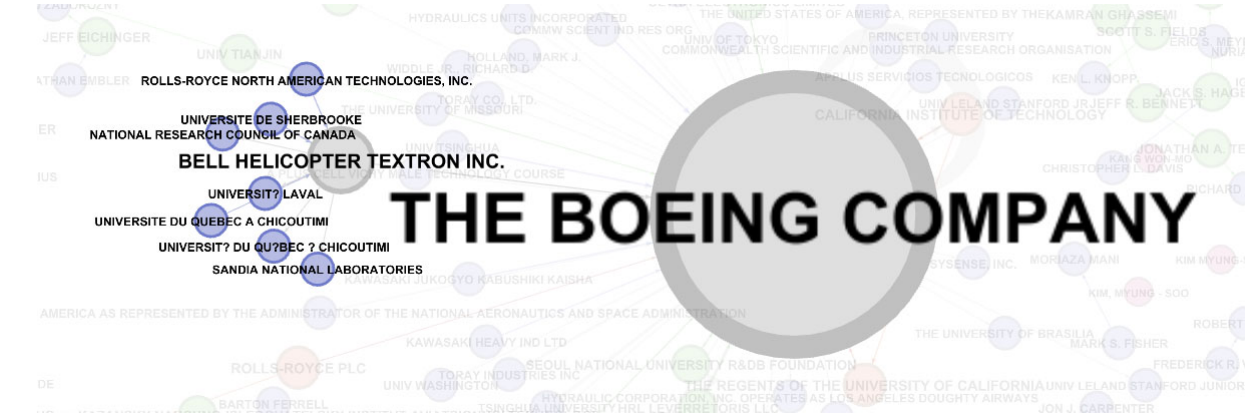
Figure 9. Network Analysis for BELL HELICOPTER TEXTRON.